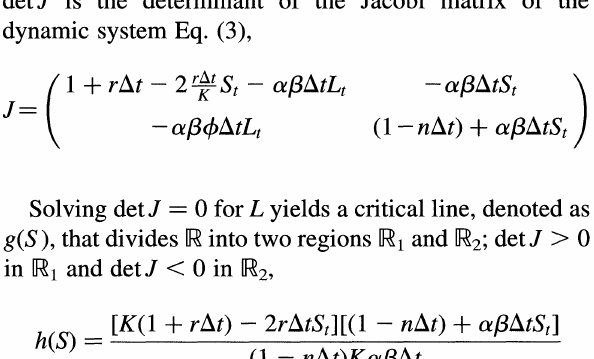
FIGURE 7 (A) invariant cycles, (B) strange